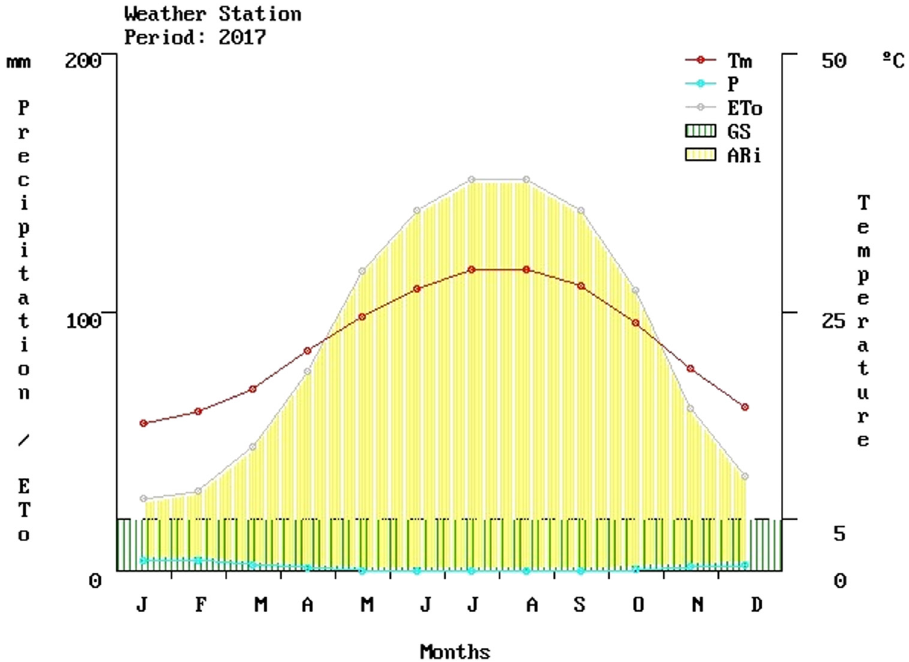
Figure 2: Volumetric graph of the year 2017 represented climate station in the studied area. T m , mean temperature in Celsius; P , precipitation ( mm ) ; ET 0 , potential evapotranspiration ( mm ) ; GS, Growing season; Ari, Aridity index.